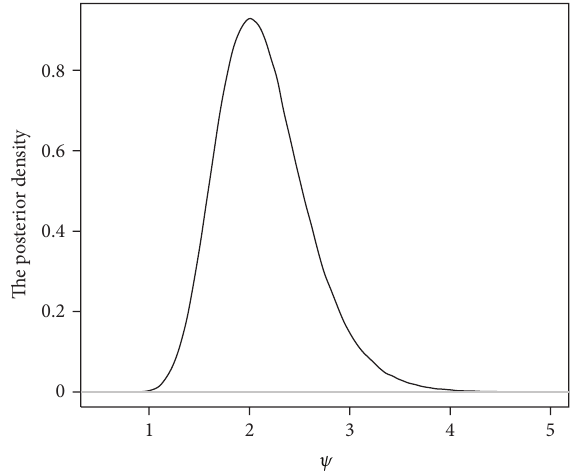
Figure 2: The posterior density of the odds ratio 𝜓 estimated by a kernel density smoother based on the second 500,000 posterior samples of 𝜃 generated by the data augmentation algorithm when the prior distribution is Dirichlet (1,1,1,1)